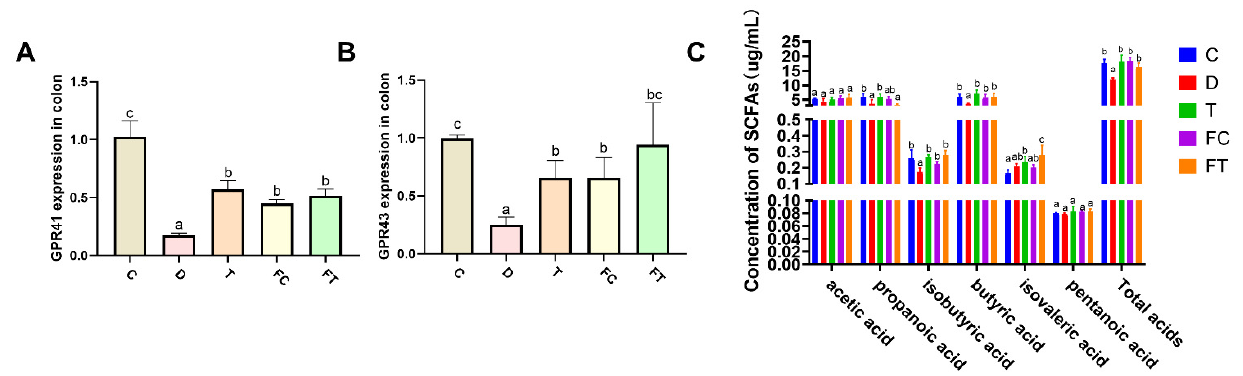
Figure 3. Taxifolin and FMT reserved the expression level of short chain fatty acid (SCFAs) receptor in colon tissue in DSS treated mice. The expression levels of SCFAs receptor GPR41 ( A ), GPR43 ( B ) in each group were detected. Data are mean ± SEM ( n = 7). ( C ) Test results of SCFAs in feces. Content in stool samples of mice. The letters abc are significant markers, and any difference with one of the same marker letters is not significant, and any difference with different marker letters is significant.